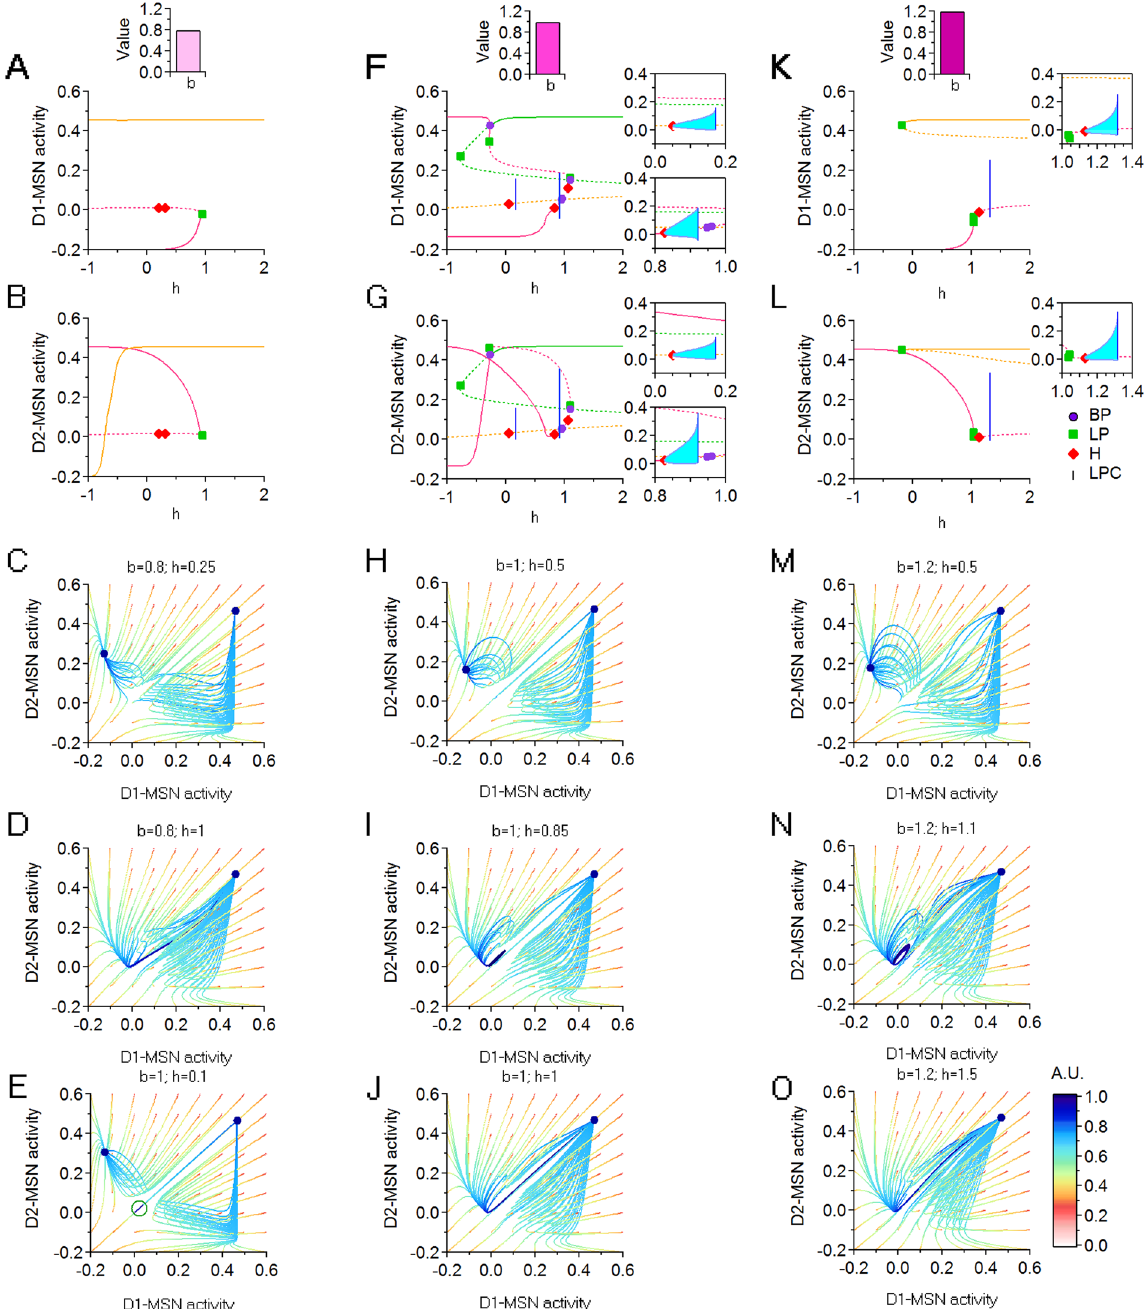
Figure 9. Dynamic transitions for b = 0.8, b = 1 and b = 1.2. ( A , B ) Bifurcation diagrams with respect to h , for D1- and D2-MSNs, when b = 0.8. ( C , D ) Trajectories in a ( D 1, D 2) phase space slice for b = 0.8 and h = 0.25 and h = 1. ( E ) As in ( C , D ), for b = 1 and h = 0.1. ( F , G ) As in ( A , B ), for b = 1. ( H – J ) As in ( C , D ), for b = 1 and for different values of h . ( K , L ) As in ( A , B ) for b = 1.2. ( M – O ) As in ( C , D ), for b = 1.2 and for different values of h